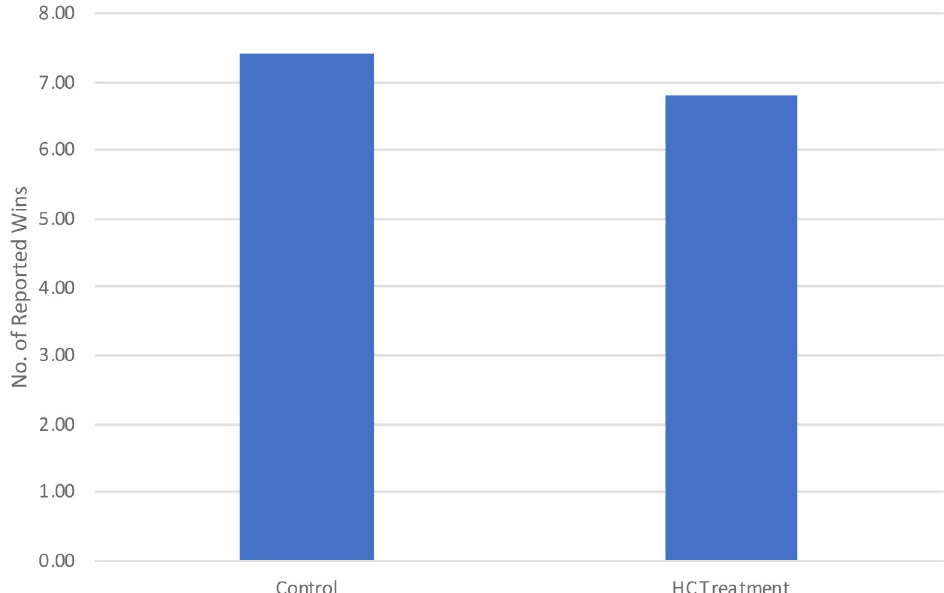
Fig 3. Comparison of the distribution of wins reported by treatment. (A) Distribution of reported wins in the control condition in comparison to the binomial distribution implied by honest reporting. (B) Distribution of reported wins in the HC treatment condition in comparison to the binomial distribution.